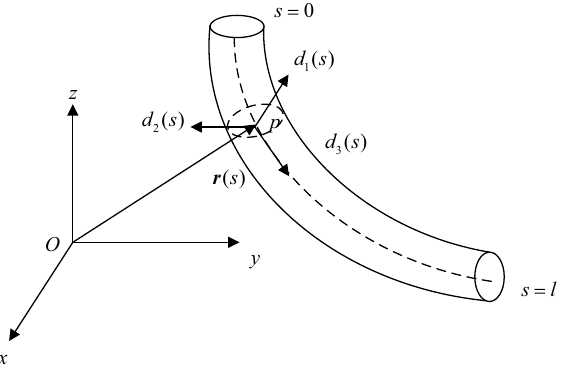
Figure 1. Spatial geometric shape of